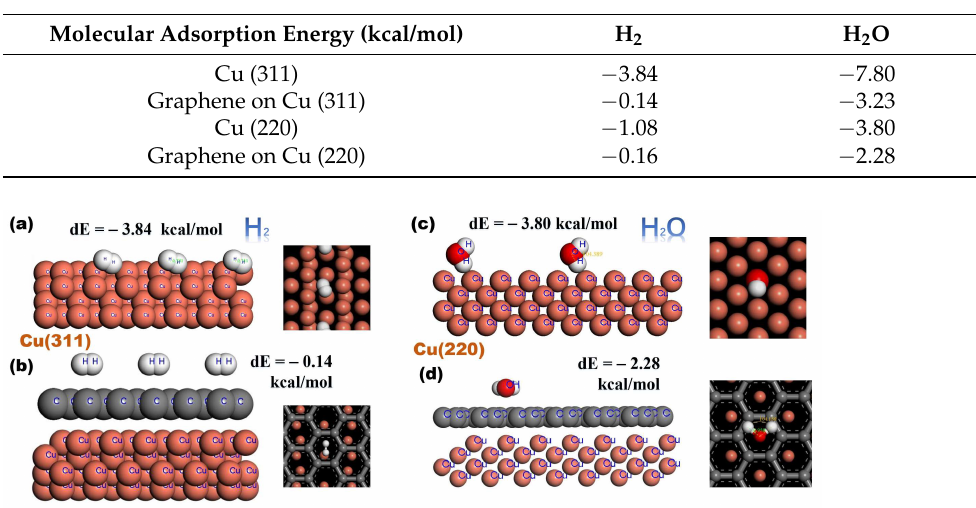
Figure 11. Molecular configurations of two typical gas molecules at the GoCu and Cu interfaces: ( a ) H 2 on Cu(311); ( b ) H 2 on GoCu(311); ( c ) H 2 on Cu(220); ( d ) H 2 on